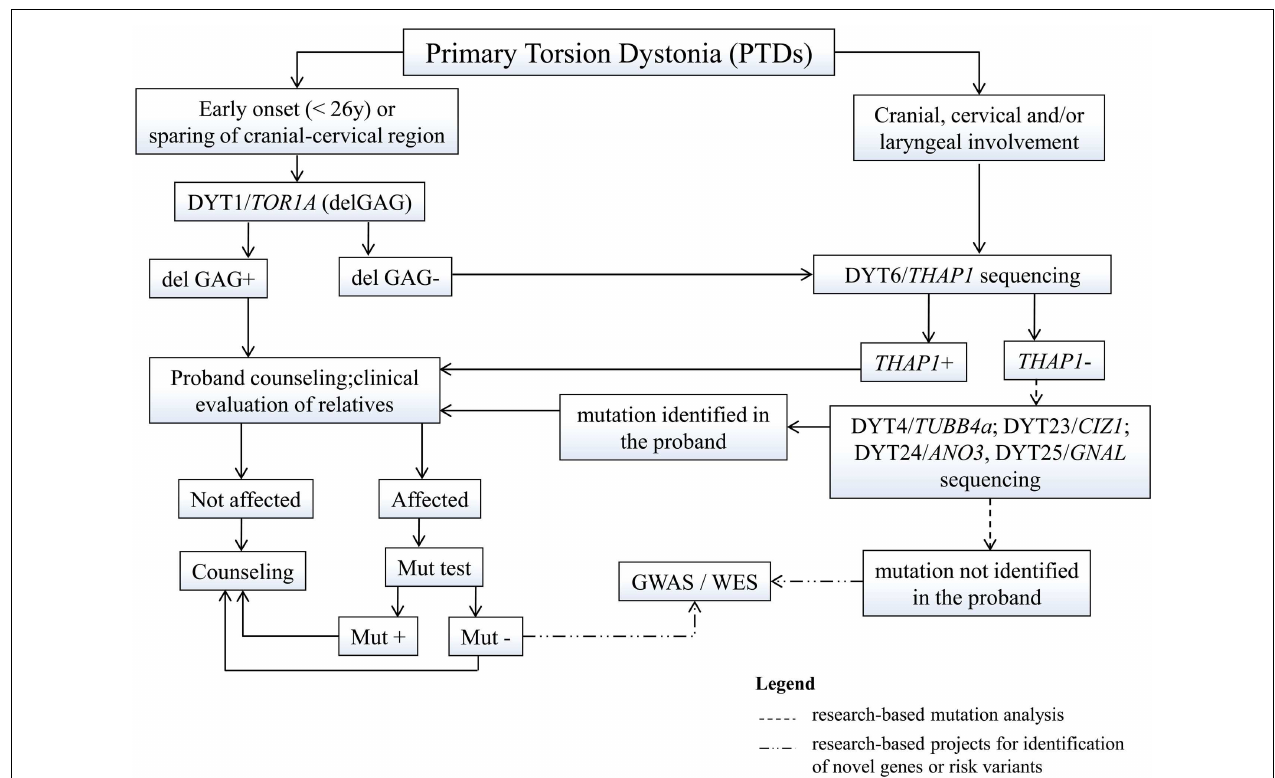
FIGURE 1 | Proposed flowchart for genetic testing in primary dystonias. GWAS, genome-wide association studies;WES, whole exome sequencing; mut,